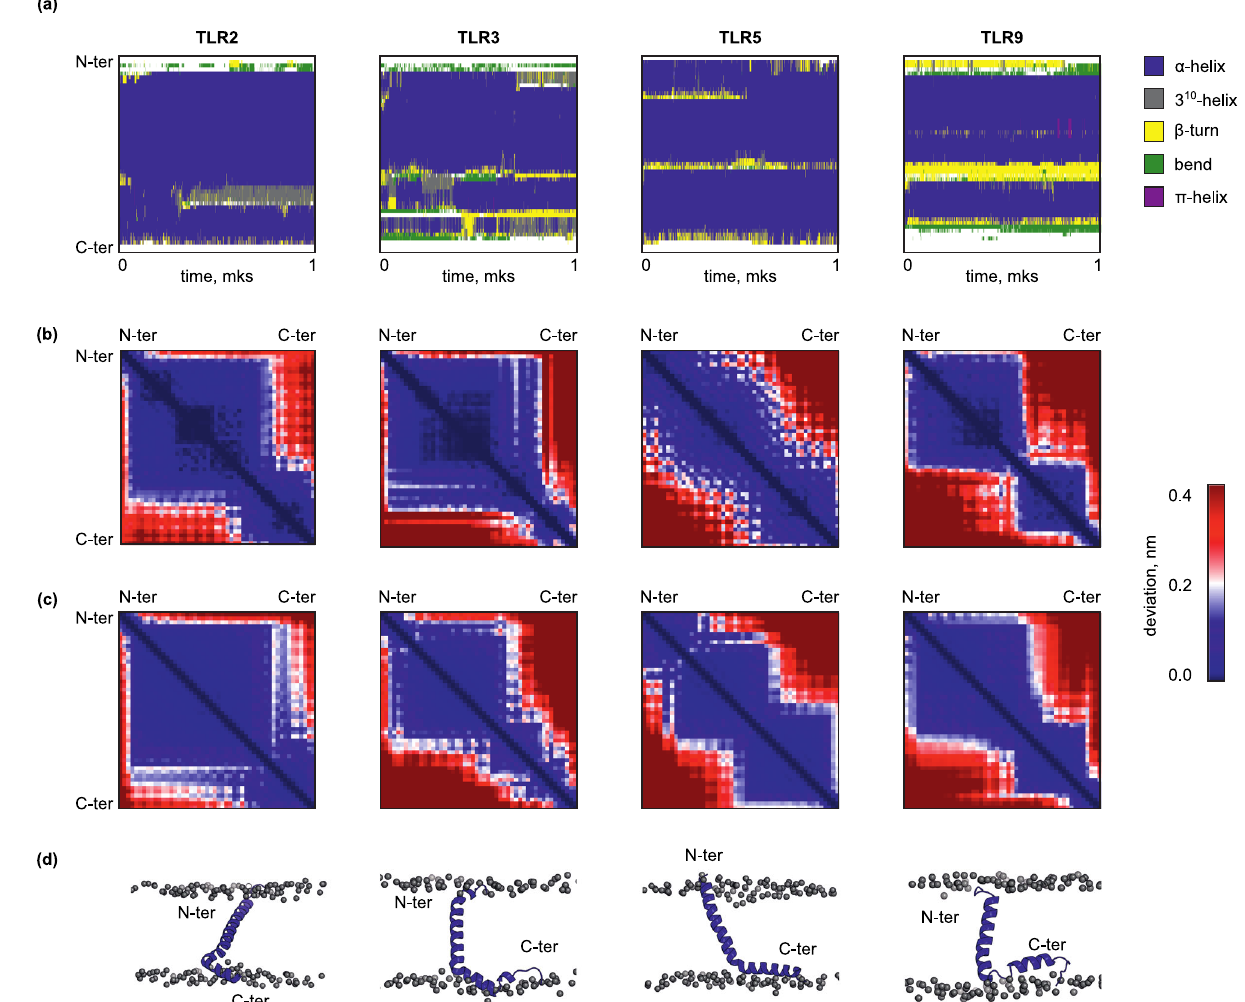
Fig. 5 | Adaptation of TLRtmjm to membrane environment. a Evolution of the secondary structure in MD. The colors of the elements of the secondary structure are given on the right. b , c Internal mobility maps, calculated by the experimental ( b ) and the simulation ( c ) sets of structures. Deviation (nm) indicates the standard deviation of the distance between the CA atoms of corresponding residues,